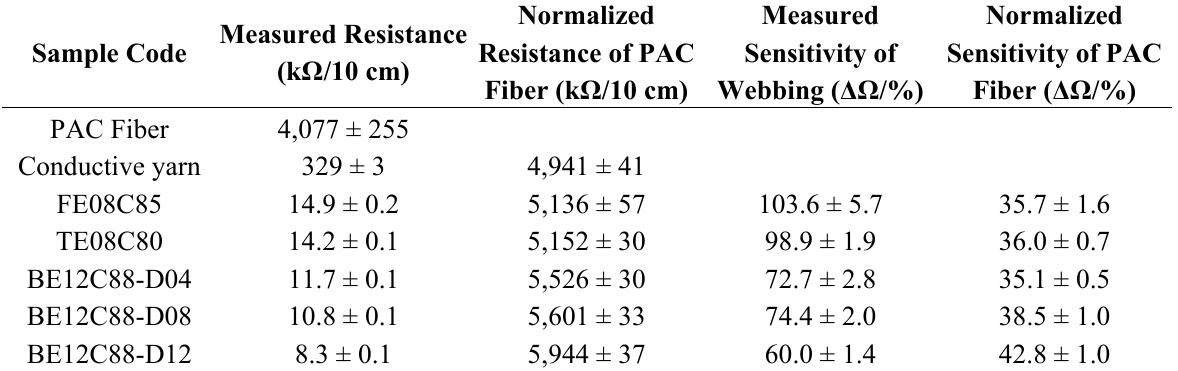
Table 3. Resistance and sensitivity of samples within a 30%